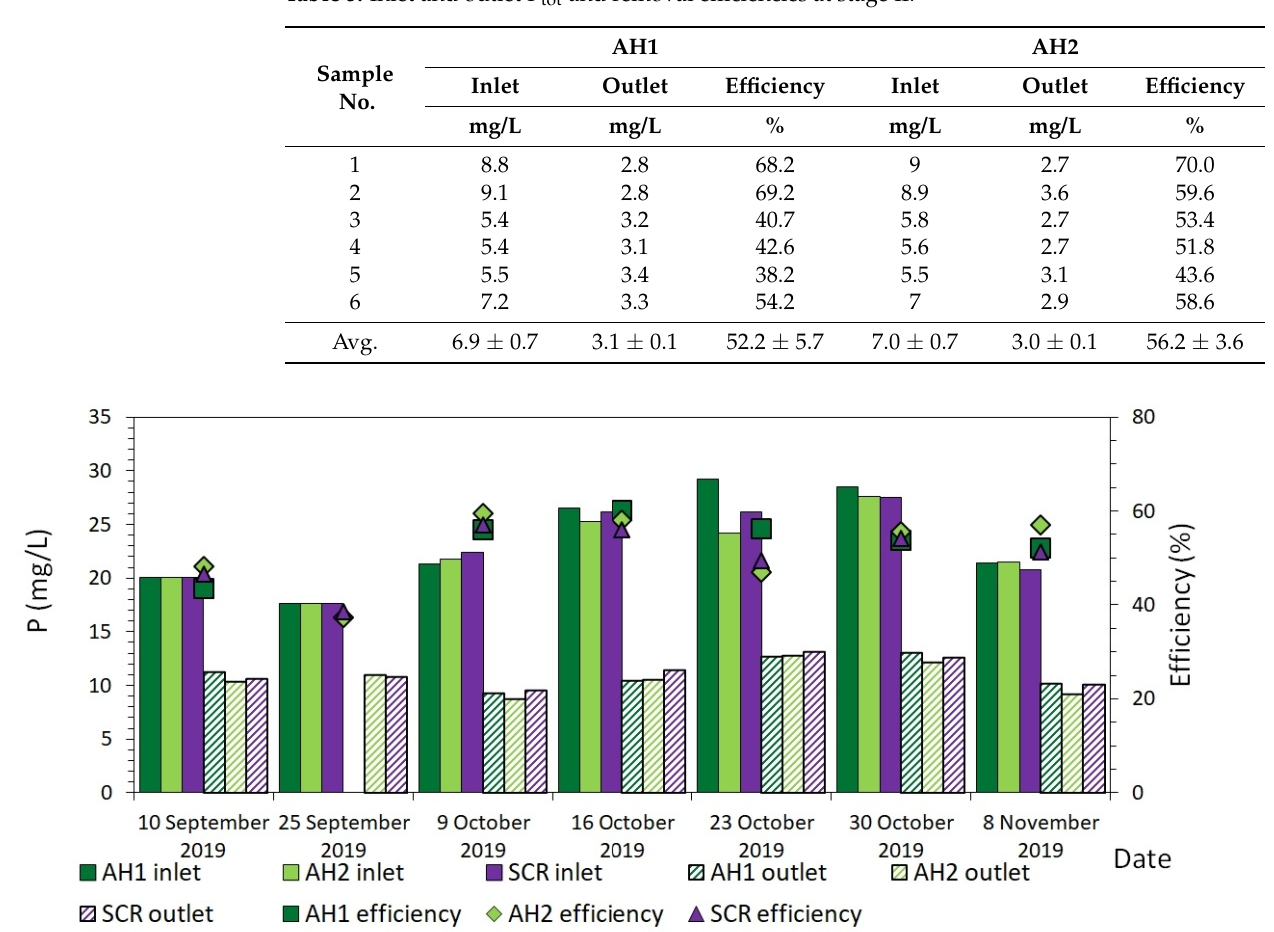
Table 5. Inlet and outlet P tot and removal efficiencies at stage II.